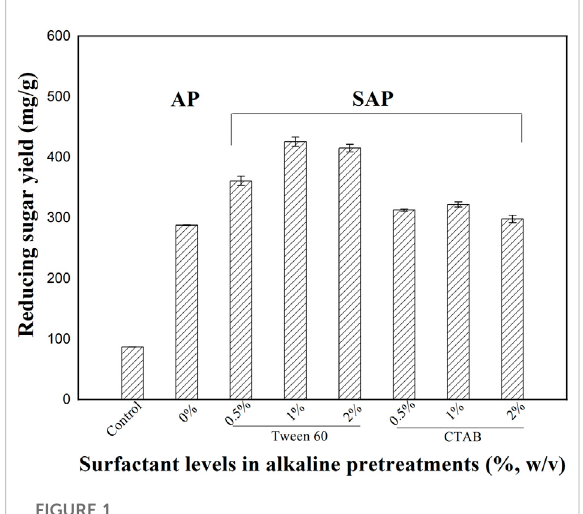
FIGURE 1 The effect of SAP with Tween 60 and CTAB surfactants on enzymatic